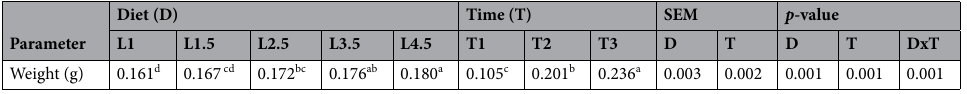
Table 1. Effects of the dietary treatment, time and interaction between dietary treatment and time on individual larval weight. L1 EE 1% diet, L1.5 EE 1.5% diet, L2.5 EE 2.5% diet, L3.5 EE 3.5% diet, L4.5 EE 4.5%